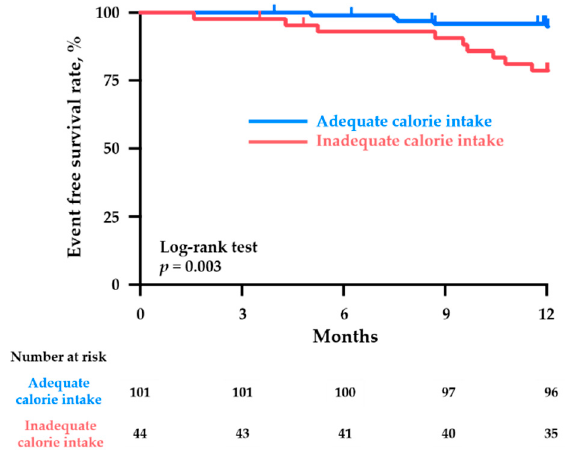
Figure 2. Kaplan–Meier curves for the cumulative event (all-cause death and HF-related hospitalization)-free ratio in the chronic HF patients with an adequate calorie intake (dietary calorie intake adequacy ≥ 60%) and those with an inadequate calorie intake (dietary calorie intake adequacy <60%).